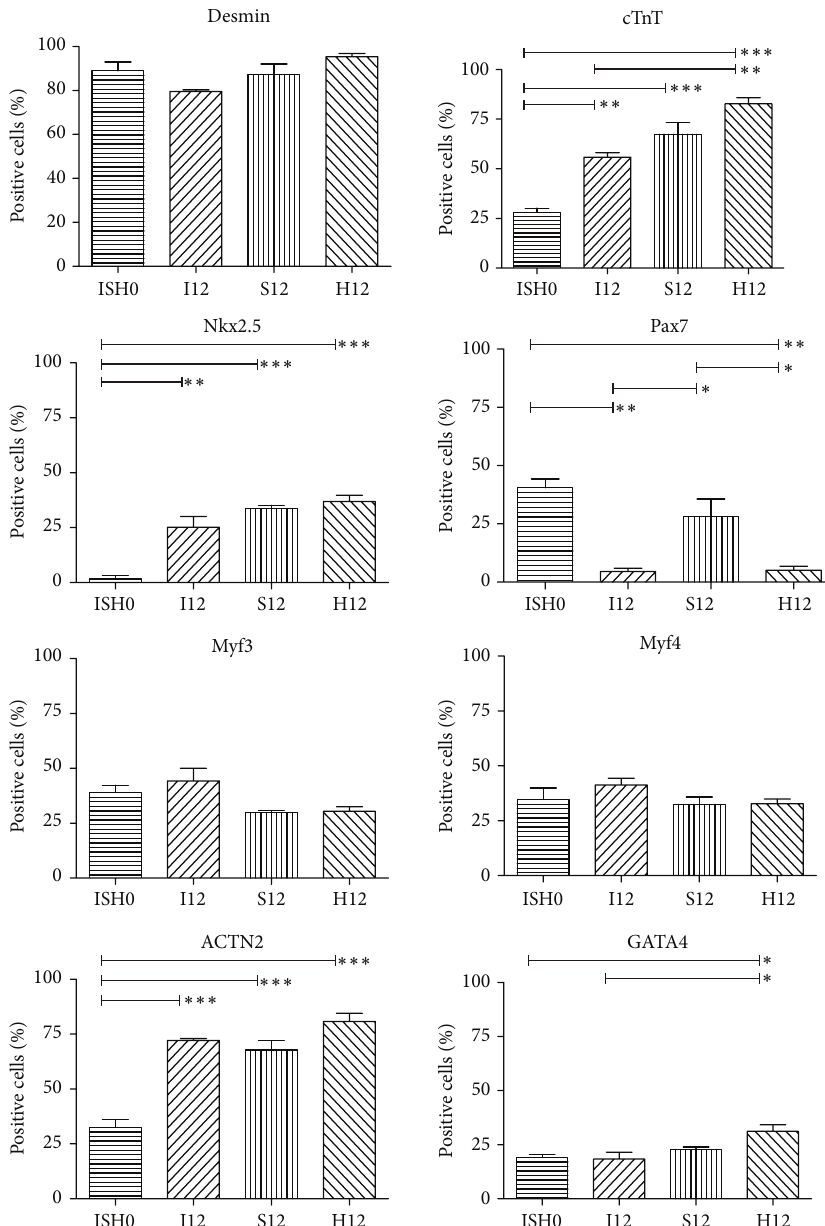
Figure 3: Immunocytochemical quantification of skeletal and cardiac muscle markers in MDSCs cultured under dynamic support. Cell clusters from the initial cell population (ISH0) and after applying different cell culture conditions for 12 days (I12, S12, and H12) were dissociated, plated, and stained for desmin, cTnT, Nkx2.5, Pax7, Myf3, Myf4, ACTN2, and Gata4. Ratios were calculated as positive cells (stained for marker) versus total cells (stained for DAPI). ∗/∗∗/∗∗∗ 𝑝 < 0.05/0.01/0.001 .